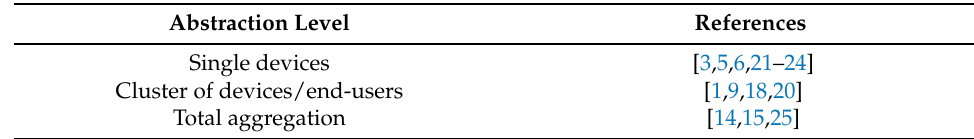
Table 1. Abstraction level of communication and referenced literature.